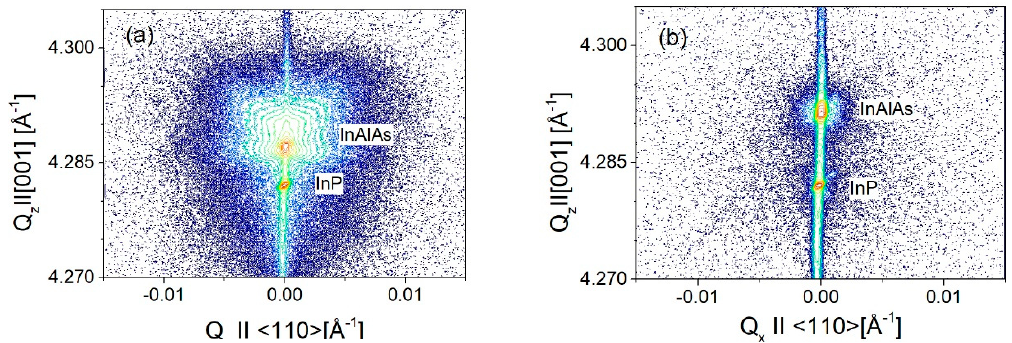
Figure 7. Reciprocal space maps of XRD intensity (contour plots) measured around 004 symmetrical reflection of In 0.52 Al 0.48 As / InP test samples for growth temperatures: ( a ) T g = 520 ◦ C and ( b ) T g = 480 ◦ C. The V / III = 26 flux ratio was used in both cases.